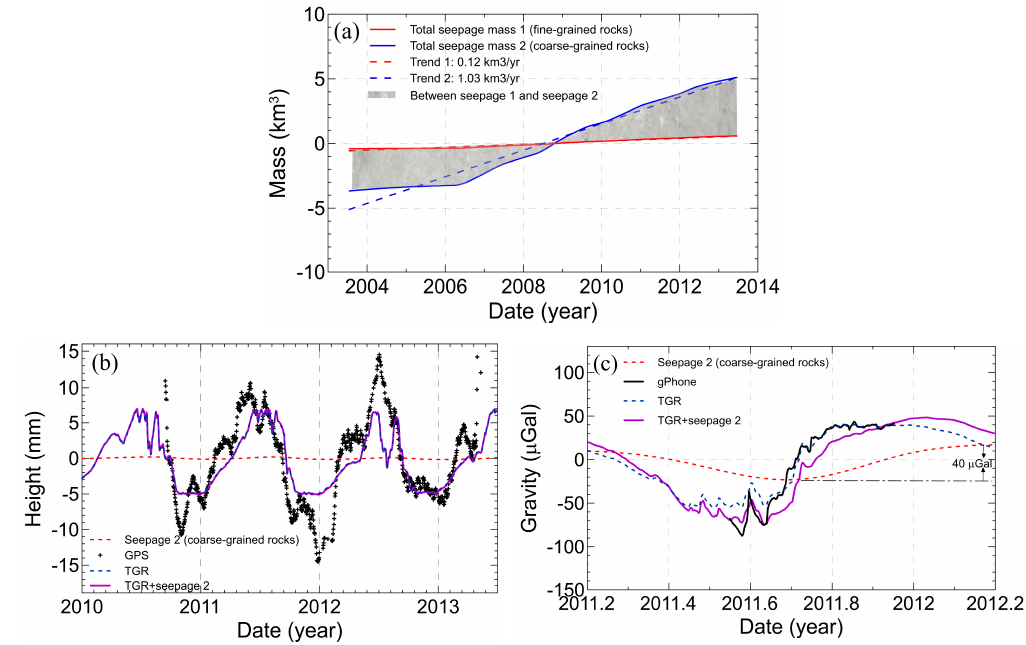
Figure 8. ( a ) Simulations of the total seepage volume surrounding TGR using two permeability coefficients: K = 7 × 10 − 7 m/s, S = 0.02 (seepage-1, red curve) and K = 7 × 10 − 6 m/s, S = 0.17 (seepage-2, blue) for fine-grained and coarse-grained rocks, respectively. ( b ) Time series of displacements from GPS measurements and model predictions (dashed blue curve represents TGR alone and solid purple curve represents TGR with seepage-2 in 2010–2013. ( c ) Similar to ( b ), but for gravity effects. Predictions of surface displacements and gravity field from simulation (3) suggest that GPS (Figure 8b) and gPhone (Figure 8c) data are in good agreement with TGR predictions without including seepage during filling the reservoir. On the other hand, including gravity effects of the seepage-2 model made the agreement worse for the gPhone data. Using the fine-grained rock parameter in the seepage model did not improve the agreement with gPhone data, but the model